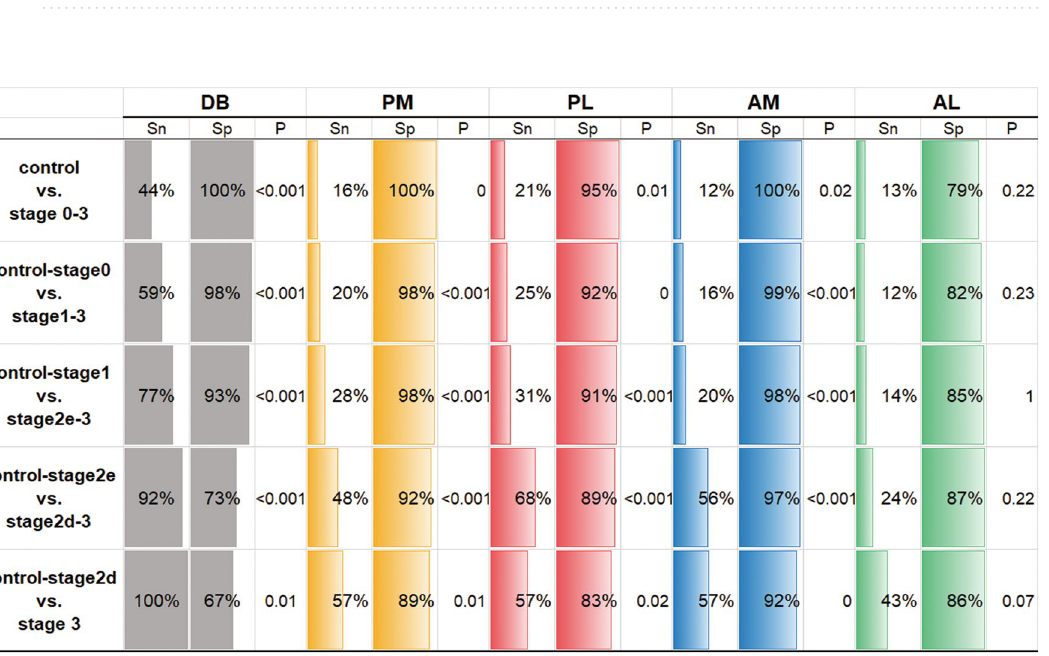
Table 2. The relation between lymphedema severity, the DB and the defects of lymphatic vessel group.